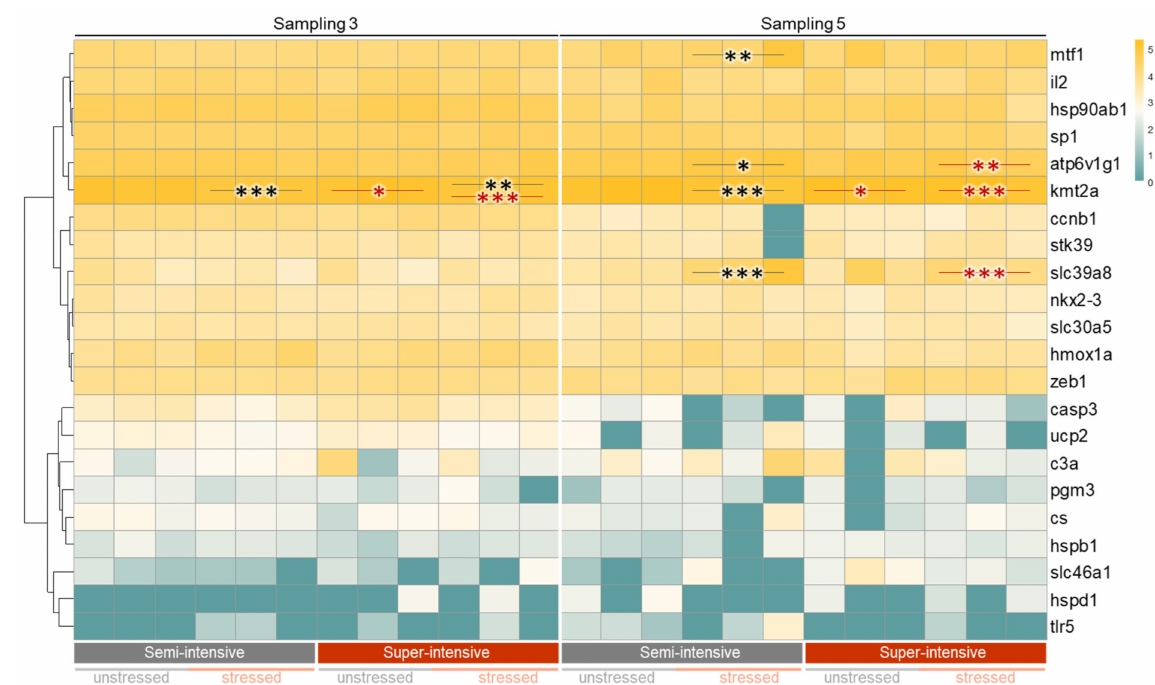
Figure 5. Hierarchical clustering of log10-transformed transcript numbers measured in the spleen of individual African catfish. The fish were kept under semi-intensive or super-intensive conditions, and individuals of both groups were exposed to stress, while a cohort remained unstressed (indicated below the heatmap). The sampling time points are indicated above the heatmap. The transcripts quantified are listed as gene symbols on the right margin; transcript levels are colored according to the scale on the left. Black asterisk(s) indicate a different expression in the stressed group compared to the matching unstressed group of the same stocking density and at the same sampling timepoint; red asterisk(s) indicate a different expression in the super-intensive group versus the semi-intensive group under the same conditions (either unstressed or stressed) and at the same sampling timepoint (*, p < 0.05; **, p < 0.01; *** p <